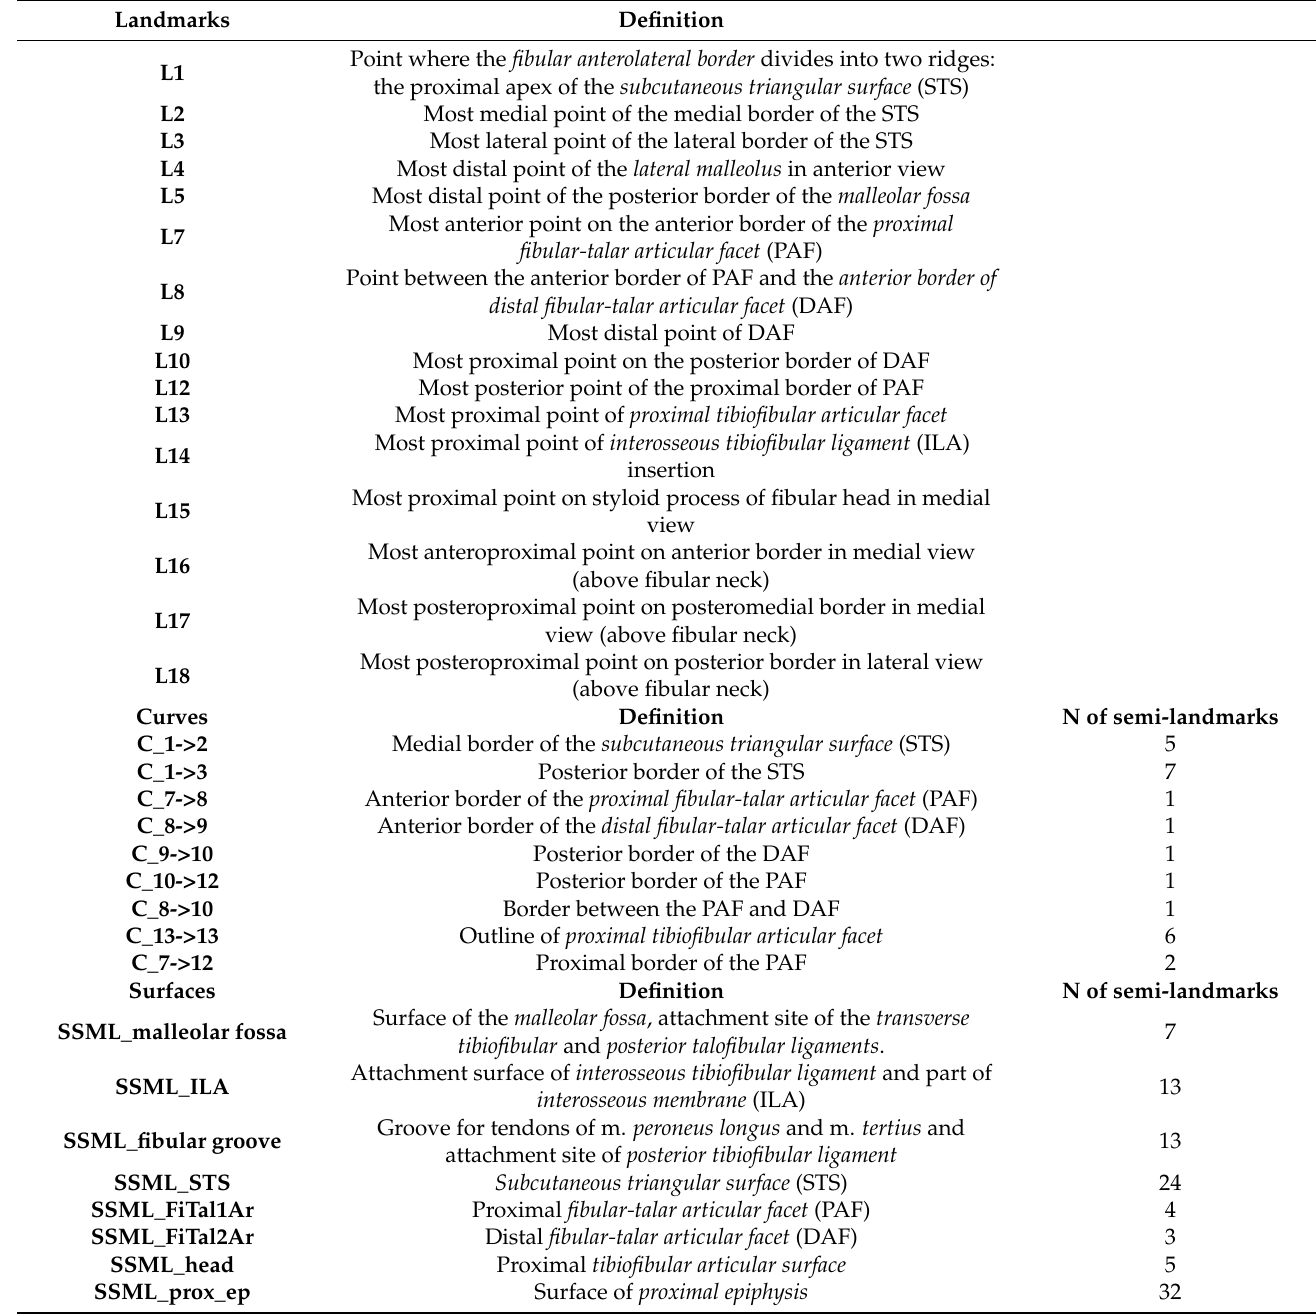
Table 2. Fibular landmarks and (semi)landmarks identification, definition, and number [37] (license: CC BY